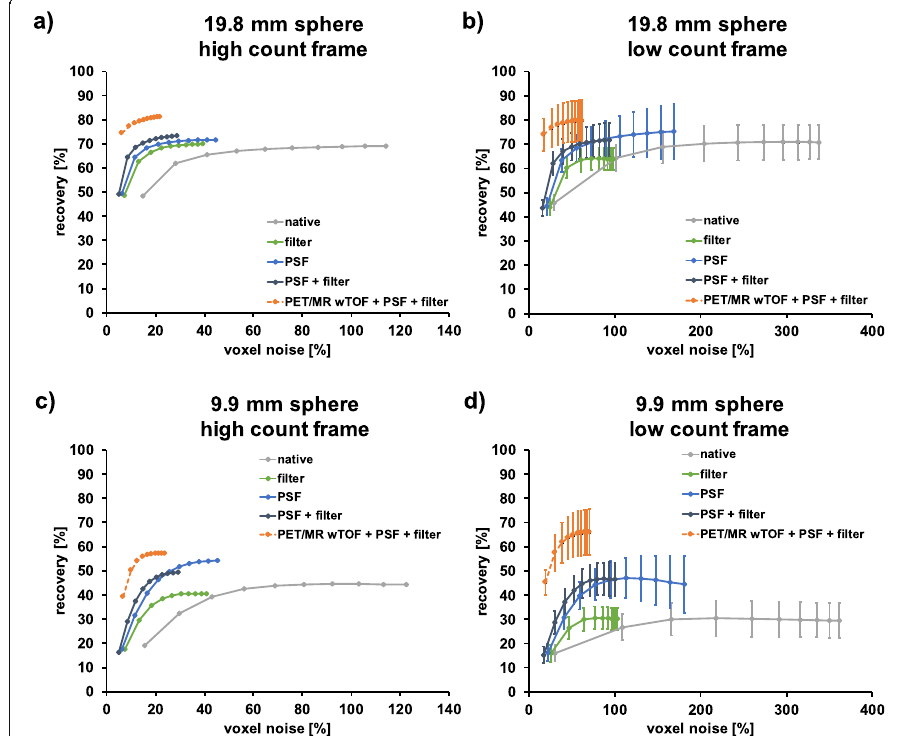
Fig. 4 HRRT RCs (%) as a function of voxel noise (%) for two different sphere sizes and for a high and low count frame for the contrast phantom (19.8 mm sphere: high count frame ( a ), low count frame ( b ); 9.9 mm sphere: high count frame ( c ), low count frame ( d )). The high count frame corresponds to ~ 135 million prompts within the frame, the low count frame to ~ 12 million prompts. Note the difference in x -axis limits. HRRT data were reconstructed without any filters (native), with a 2-mm Gaussian filter (standard in-house reconstruction for human data), with PSF, and with PSF correction and 2-mm filter using 16 subsets, respectively. High count data were analyzed based on a single realization while low count data were based on five replicates. Each point represents an OSEM iteration, and the number of iterations increases from left to right. The dotted line represents the PET/MR reconstruction (wTOF, PSF, 3.5-mm Gaussian filter) used